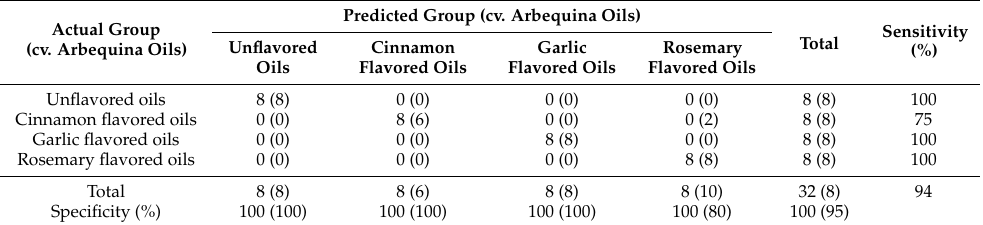
Table 3. Confusion matrix for the E-nose-MOS-LDA-SA model: training and LOO-CV (in parentheses)